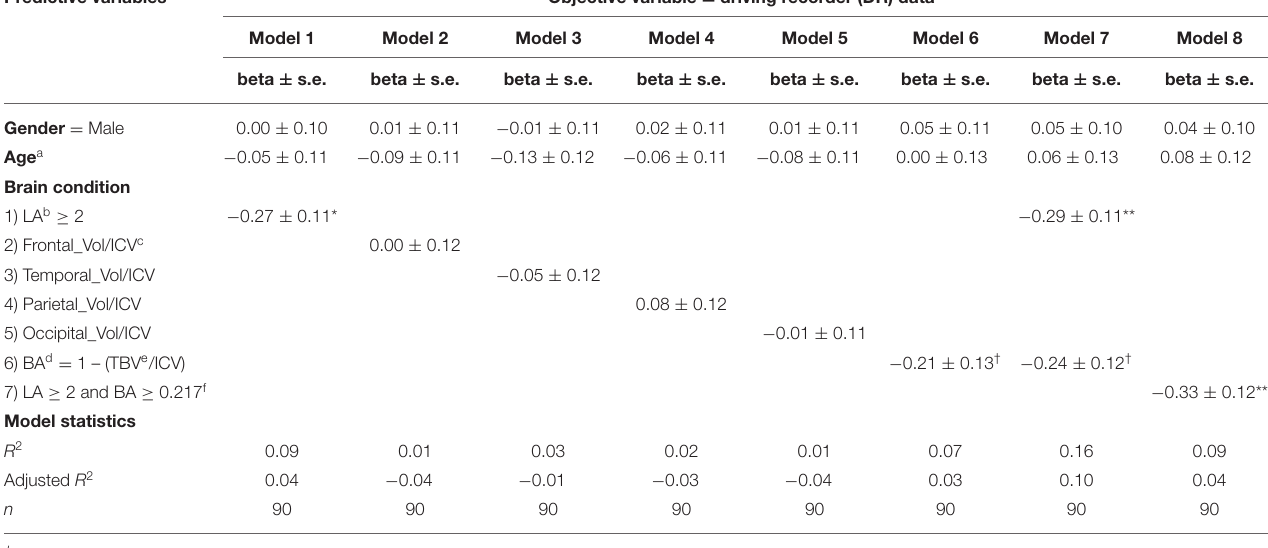
TABLE 3 | Regression analysis results with driving recorders